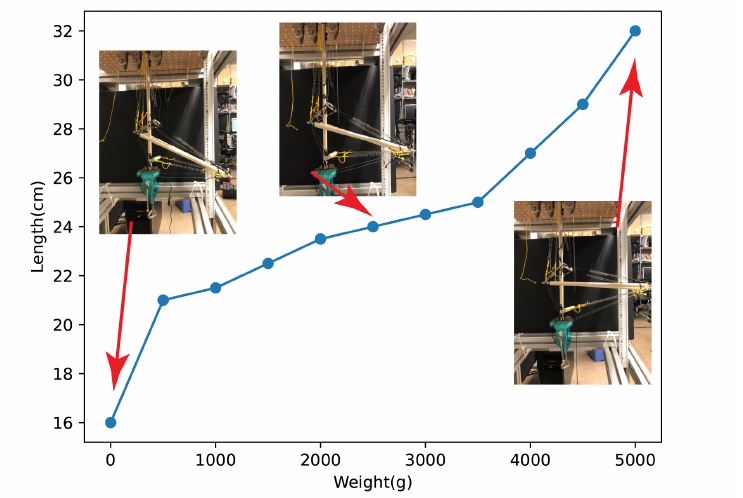
Figure 15. Graph of the height of the tip of the lower arm when it is pulled upward by weights. The height of the tip with no weight is 16 cm from the base of the device. The embedded images show the states corresponding to the